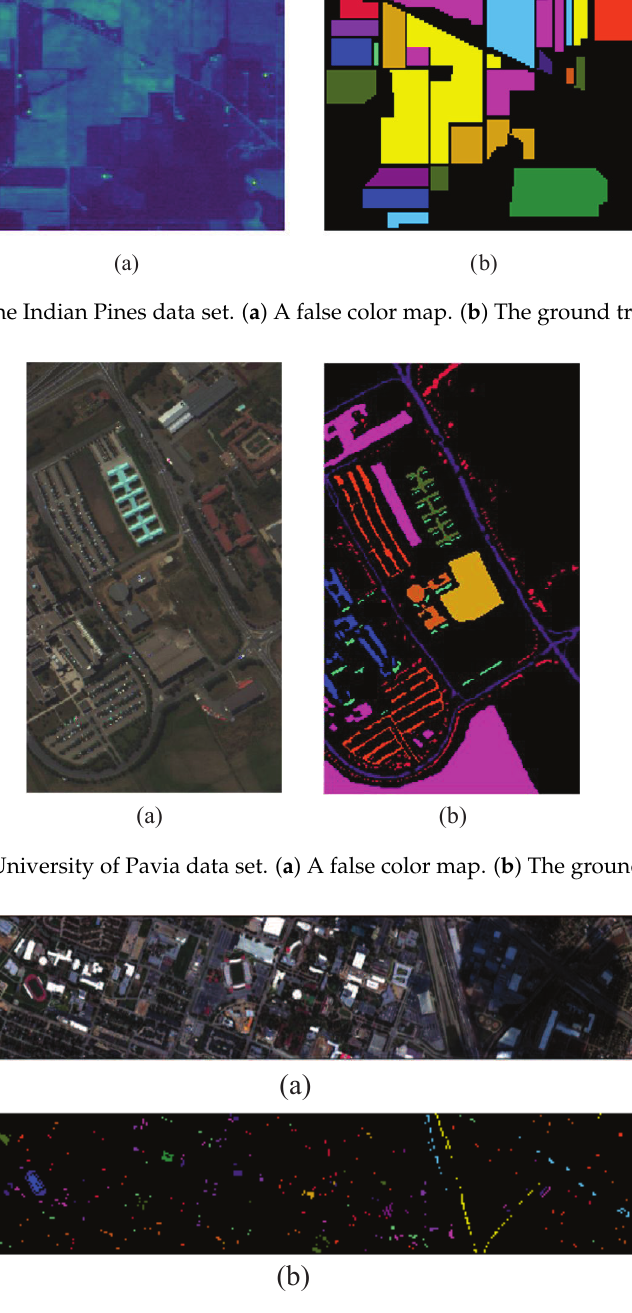
Figure 6. The Grss_dfc_2013 data set. ( a ) A false color map. ( b ) The ground truth